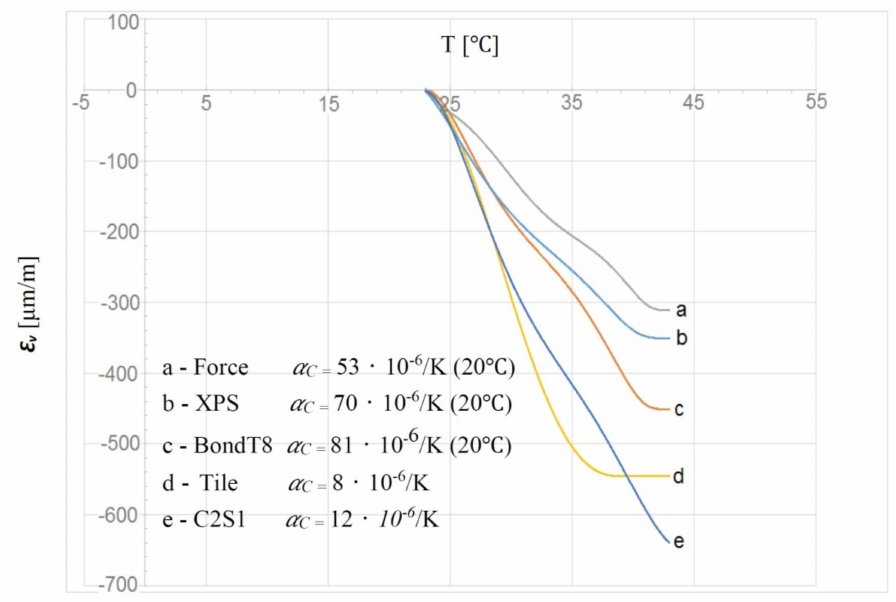
Figure 13. Temperature reactions of strain gauge deformation E v mounted on different measuring